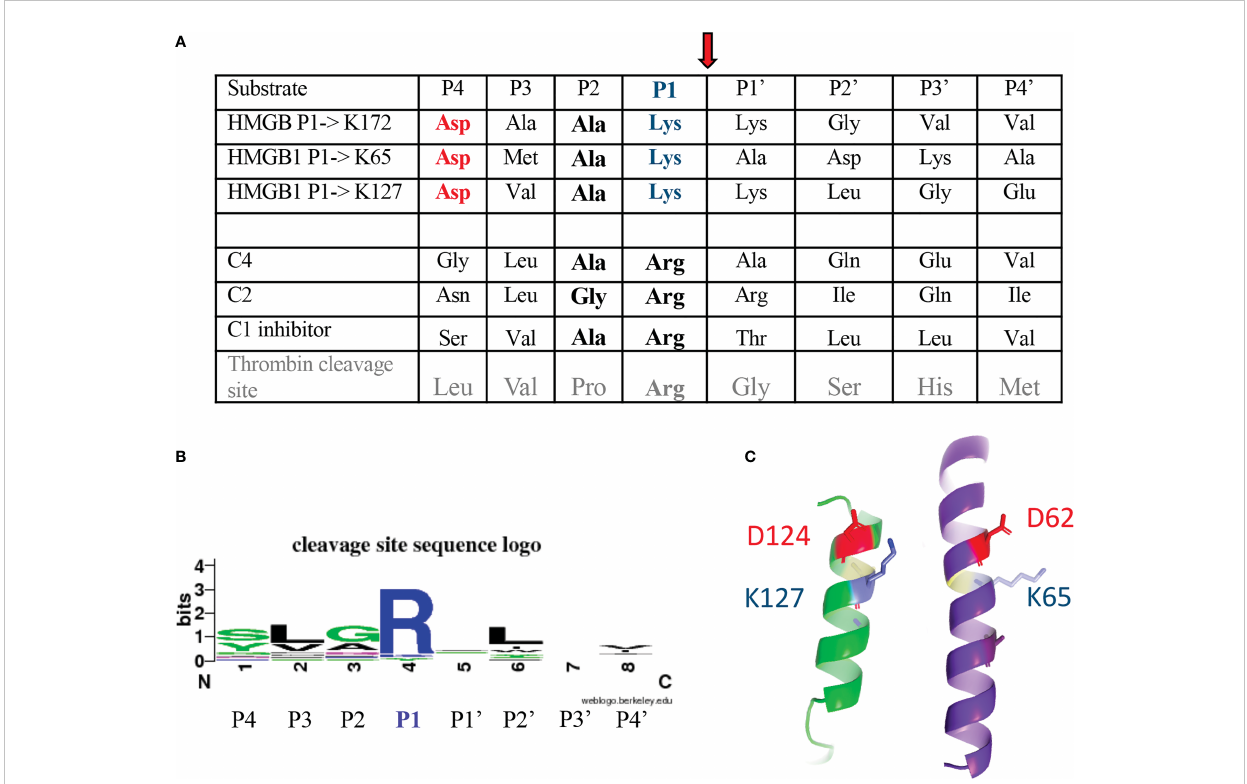
FIGURE 5 C1s cleavage sites in HMGB1 as compared to other targets. (A) Sequences upstream and downstream the C1s cleavage site are shown using the standard P4 to P4 ’ nomenclature, with cleavage of the scissile bond between P1 and P1 ’ residue (see red arrow). This terminology was used to de fi ne the extended interactions with different S4 to S4 ’ enzyme subsites of the P4 to P4 ’ sequence, these interactions de fi ning the speci fi city of the proteases (43). The classical C1s targets are its two C4 and C2 substrates, leading to the activation of the complement system, as well as its regulator, C1-inhibitor. (B) The schematic cleavage site sequence logo found in the Merops database (25), based on 20 cleavages, is shown for comparison. The corresponding cleavage pattern is syg/Lv/GAq/R/-/L/-/vi, with a cleavage after arginine (R). (C) The cleavage sites newly identi fi ed in HMGB1 are found in helical contexts, this assumption being stronger for K65 and K127, and putative/transient for K172. In this con fi guration, the P4 aspartic acid residue (red) is close to the target P1 lysine (blue). This helical structure likely needs to unwind locally during cleavage.